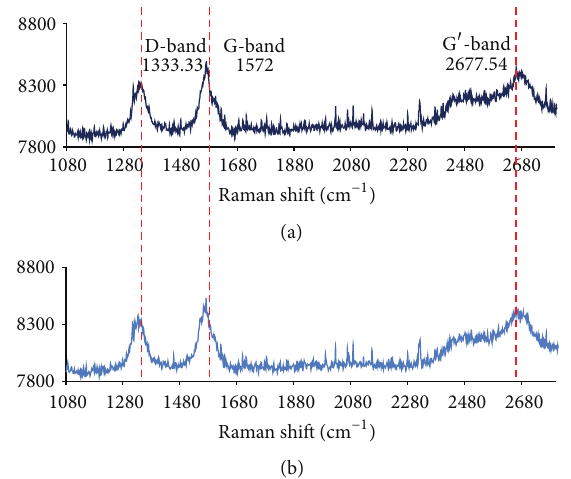
Figure 4: Raman spectra of (a) 21 hrs f-MWCNTs in comparison to (b) MWCNTs.